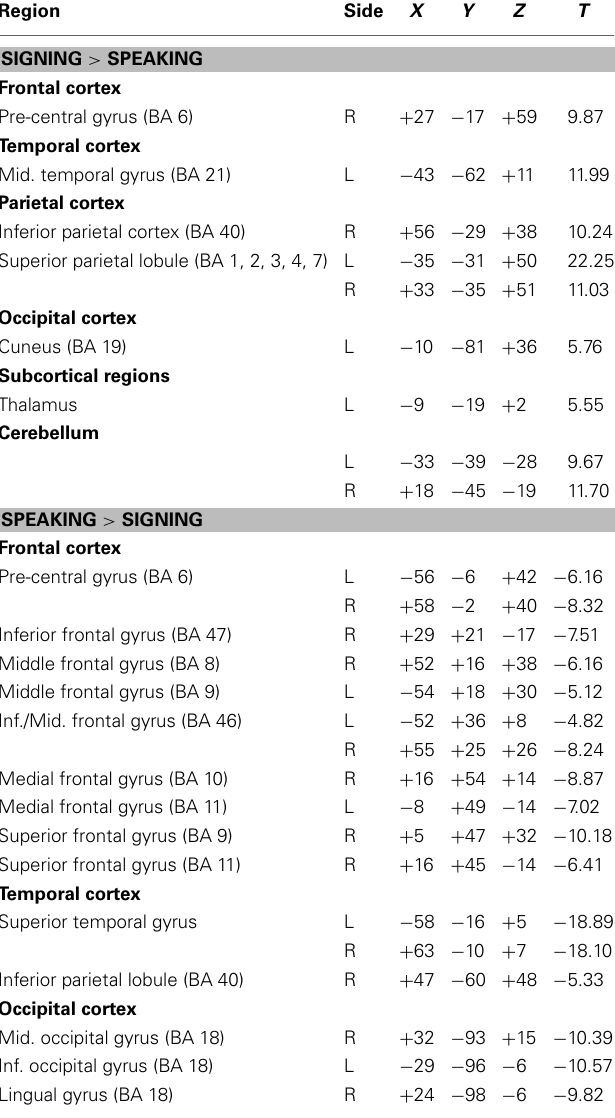
Table 1 | Summary of PET activation results for the comparison between signing and